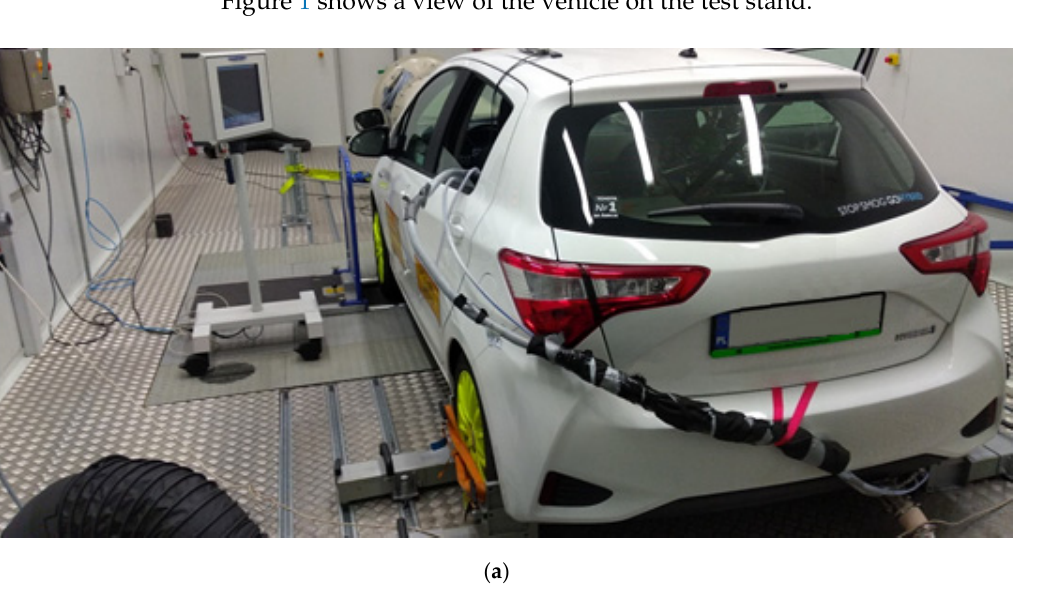
( b ) Figure 1. Test stand: ( a ) photograph of a hybrid vehicle on the test bench, ( b ) test stand scheme: 1— Tested vehicle, 2—Chassis roller, 3—Climate chamber, 4—Driver’s assistance monitor, 5—Chassis dynamometer control system, 6—Constant volume sampling system, 7—Exhaust gas analysis sys- tem, 8—Exhaust gas system, 9—Control room, 10—Cooling fan, 11—Remote mixing unit. The tests were carried out for the New European Driving Cycle (NEDC), under am- bient temperature conditions in the climate chamber (20 ± 1 °C). In this paper, tests were conducted for three dynamometer load settings, which are summarized in Table 3. Table 3. Coefficients of resistance and equivalent inertia. Parameter